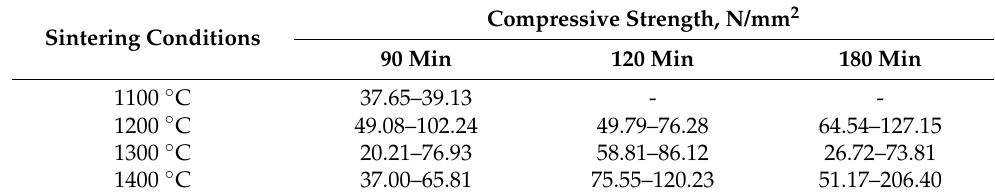
Table 6. The compressive strength of the specimens sintered at various sintering times.